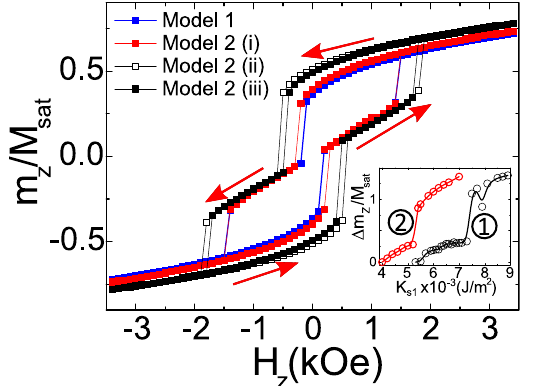
Figure 5. Simulation of the normalized (by M sat ) perpendicular to the interface z component of the magnetization of the interfacial layer of the 10 nm thick Fe layer. In MgO/Fe/MgO a PMA of 6.35 × 10 − 3 J/ m 2 has been used. The inset represents the variation of the maximum normalized magnetization jump during the spin reorientation transition on K s 1 when simulated within the model M 2 i for two different saturation magnetizations. This inset provides estimation of the anisotropy needed to create the competing anisotropy conditions in MgO/Fe(10 nm)/MgO. Curve 1 uses a constant value of M sat = 1700 × 10 3 A / m while curve 2 uses a 25% reduced interfacial values of M sat . The red arrows indicate the magnetic field sweep